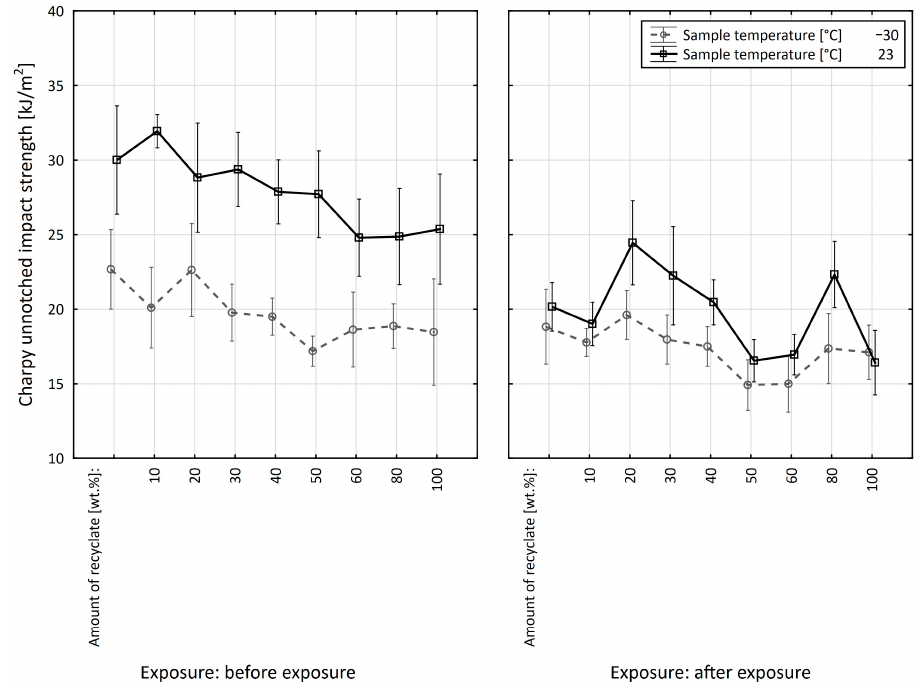
Figure 14. Dependence of the mutual interaction of the sample temperature and the exposure of the sample on the value of the unnotched impact strength of PBT.